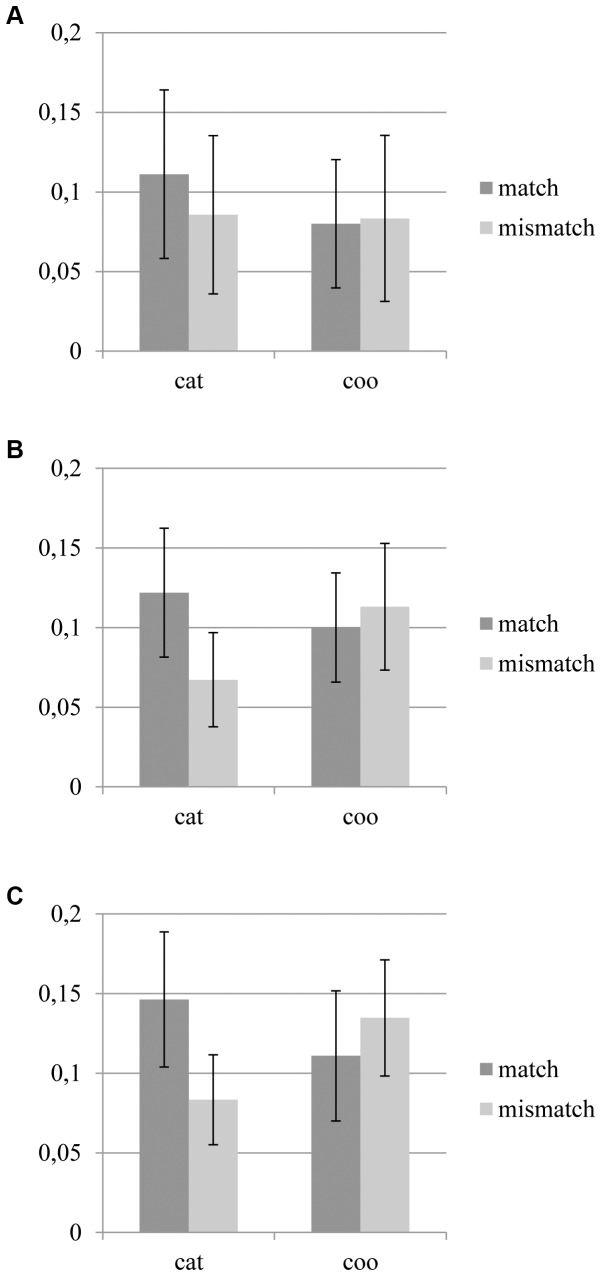
Mean regression coefficients of the retention interval between the first and second stimulus for A) V1, B) V2, and C) V3.Means are presented for both the categorical (cat) and coordinate instruction (coo) as well as the regions that would match and mismatch in comparison to the first stimulus. Error bars represent the standard error of the mean (SEM).